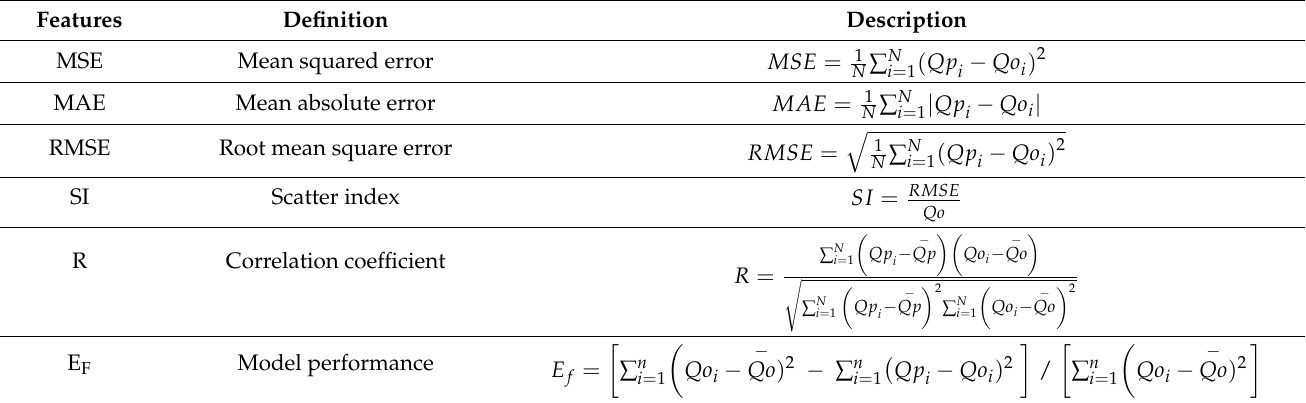
Figure 3. Flowchart of ANN and SVM models used for wave-overtopping prediction.